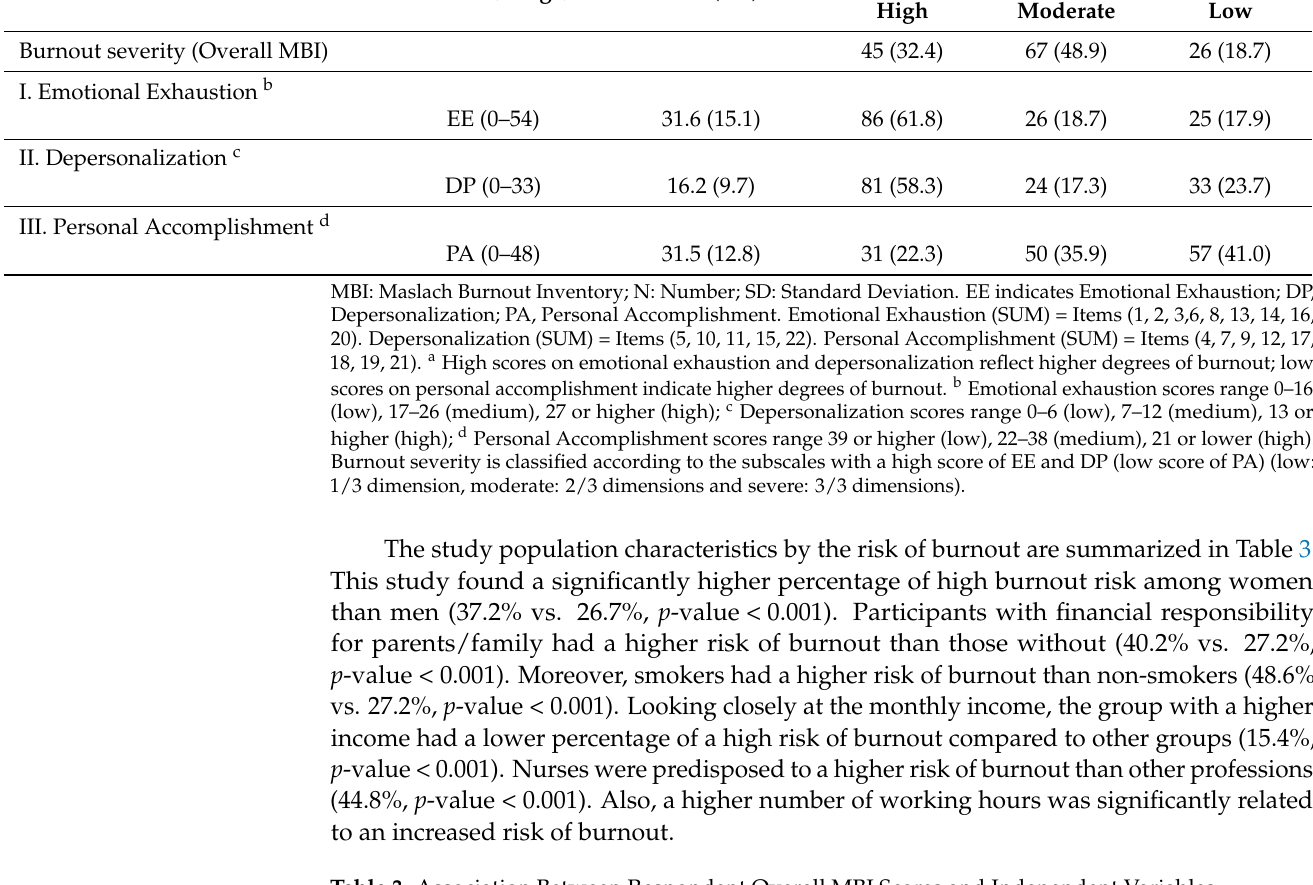
Table 3. Association Between Respondent Overall MBI Scores and Independent